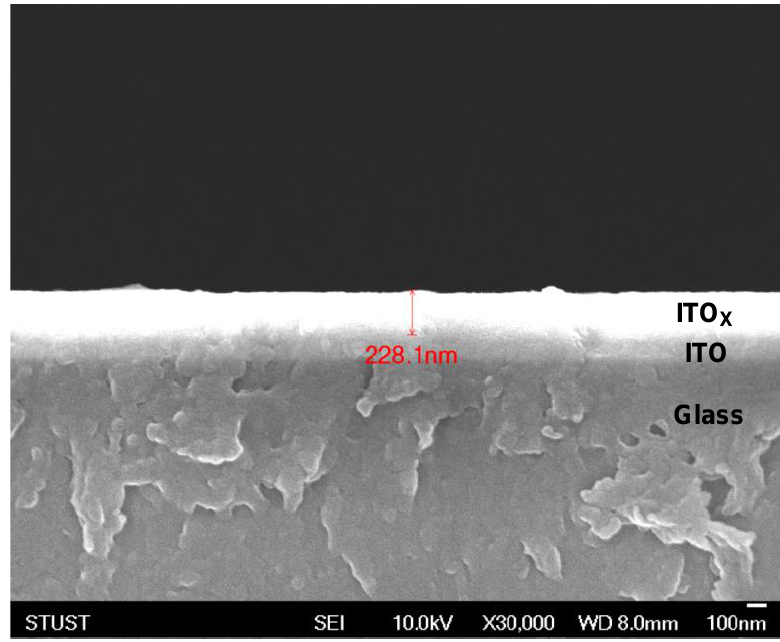
Figure 4. The SEM cross-section image of the as-deposited ITO X thin film for 50% different oxygen growth procedure parameters.